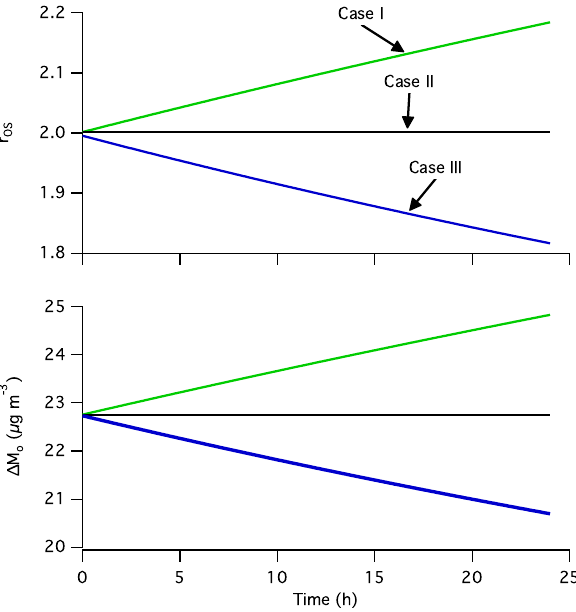
Fig. 13. Effect of 24 h of wall loss on the mass distributions in Fig. 12. The top panel shows the suspended particle organic-to- sulfate ratio, r OS , as a function of time for each case, and the bot- tom panel shows the upper bound wall-loss corrected organic mass concentration as a function of time for each